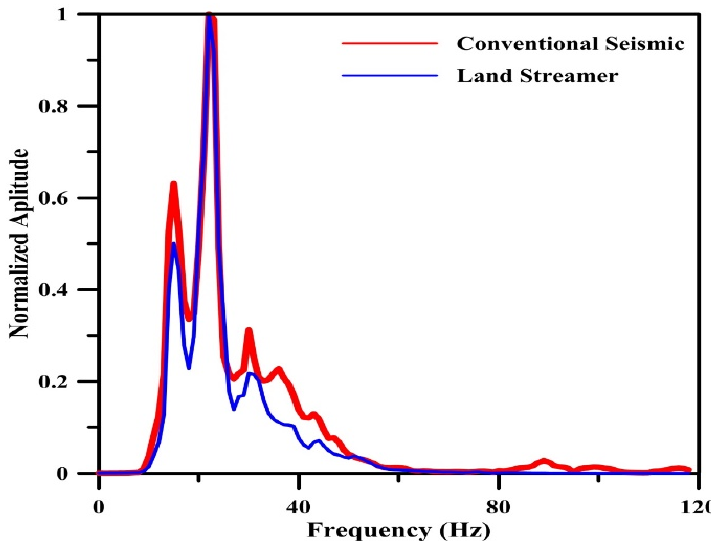
Figure 4. The frequency-offset spectrum of both conventional (red) and land-streamer (blue) data sets.